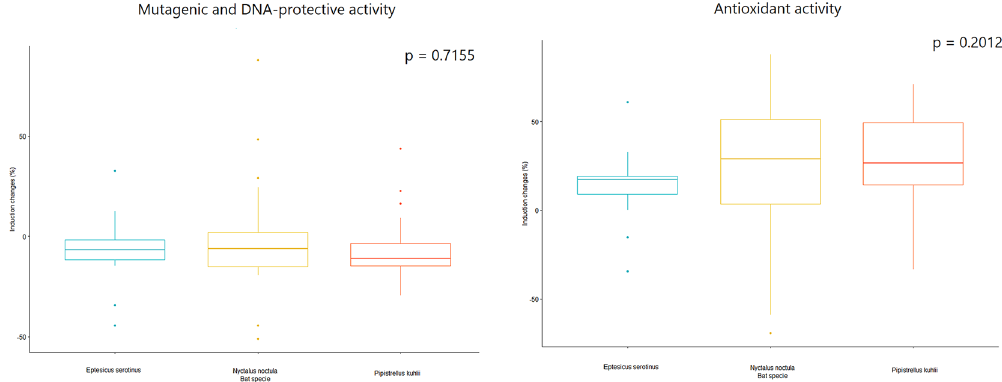
Figure 3. Results of the comparison of median values of mutagenic and antioxidant activity of lactobacilli and spore-forming bacilli isolates between different bat species by the Kruskal–Wallace